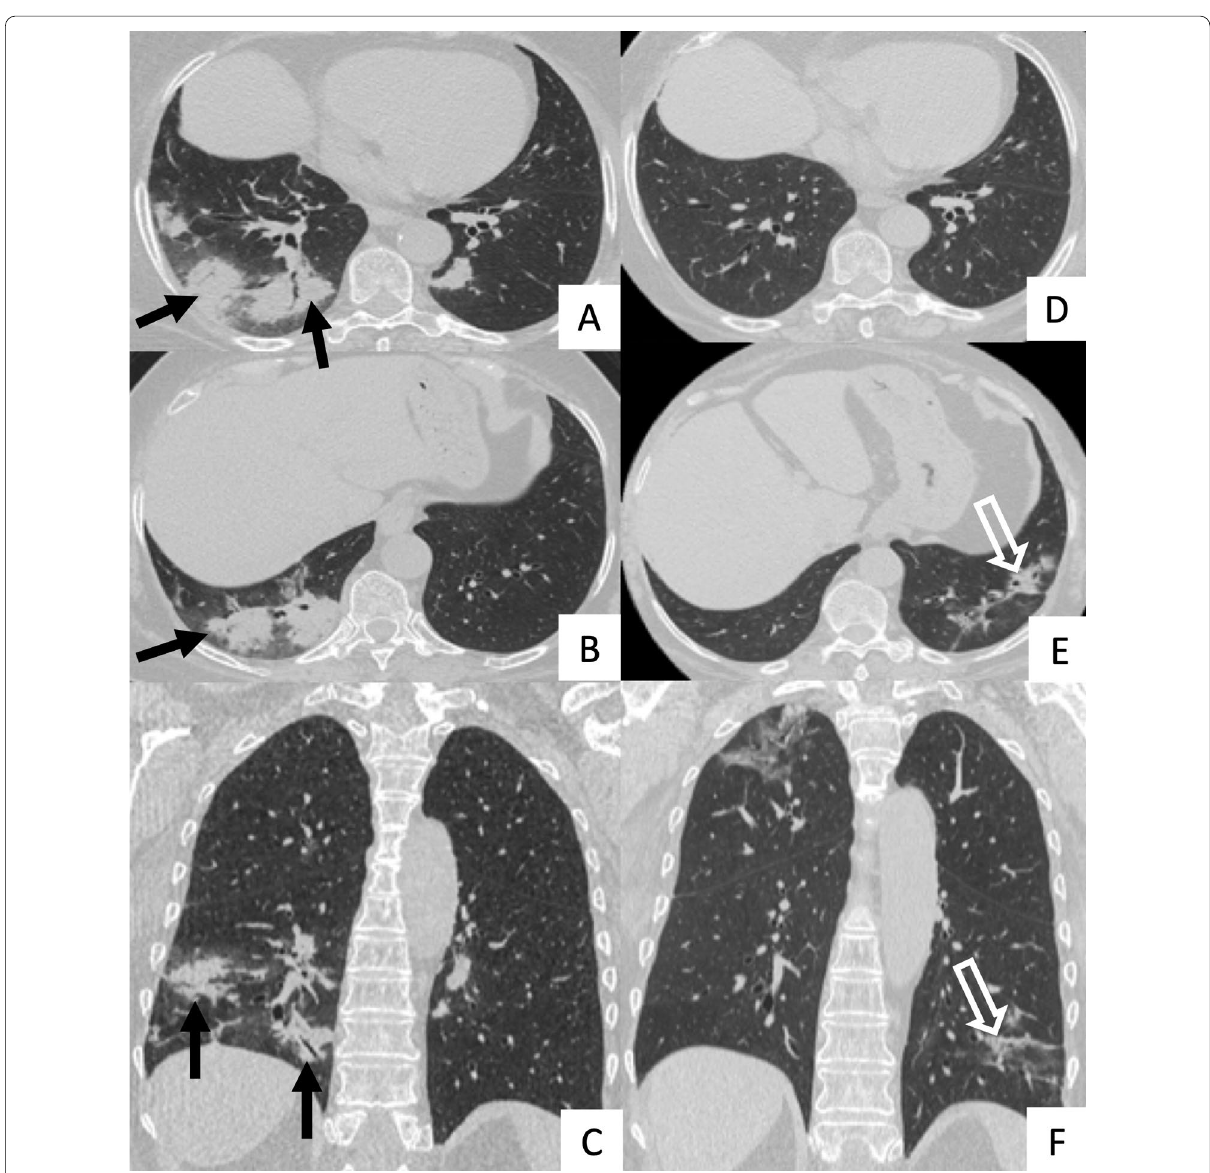
arrows); the “air bronchogram sign” is clearly recognizable. Follow-up HRCT images ( D – F ) demonstrate the typical evolution of organizing form, with tendency to migration and location changing (empty white